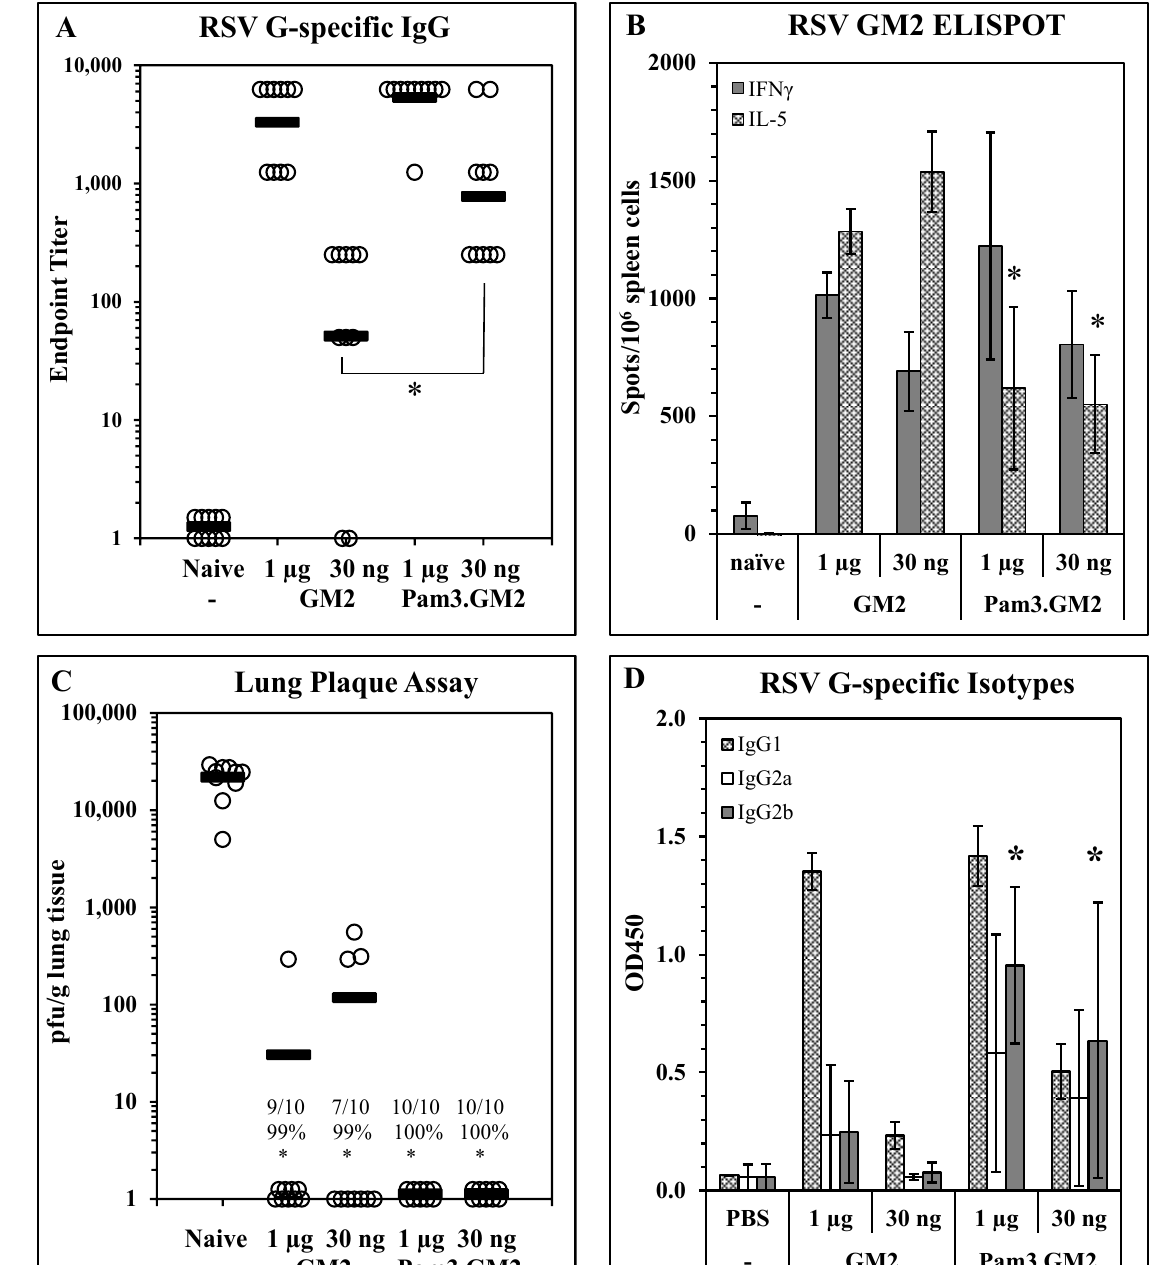
Figure 3. Improvement of immunogenicity and efficacy of LbL-MP by addition of TLR2 ligand Pam3Cys. BALB/c mice were immunized on days 0 and 21 with the indicated doses of GM2 or Pam3.GM2 LbL-MP, challenged with RSV on day 35, and sacrificed for plaque assay on day 40. ( A ) Day 28 post-boost serum antibody titers measured by RSV G protein ELISA. Endpoint titers of individual mice (open circles) and group means (bars); * p < 0.05. ( B ) Day 28 spleen cell ELISPOTs restimulated in vitro with a pool of M2 81–95 and G 169–198 peptides. Mean ± SEM spots/10 6 cells of 3 mice/group; * p < 0.05 by t -test compared to the corresponding dose level of GM2. ( C ) Lung viral titers 5 days post-challenge. Number of plaques per gram of lung tissue for individual mice (circles) and group means (bars). Insets show number of mice with no detectable plaques ( n = 10 mice per group), average % reduction in plaques per group, and * p < 0.05 compared to the naïve group. ( D ) Day 28 serum G-specific antibody isotype levels measured by ELISA. Mean ± SEM of 10 mice per group at 1:50 serum dilution. * p < 0.05 compared to the same dose level of GM2.